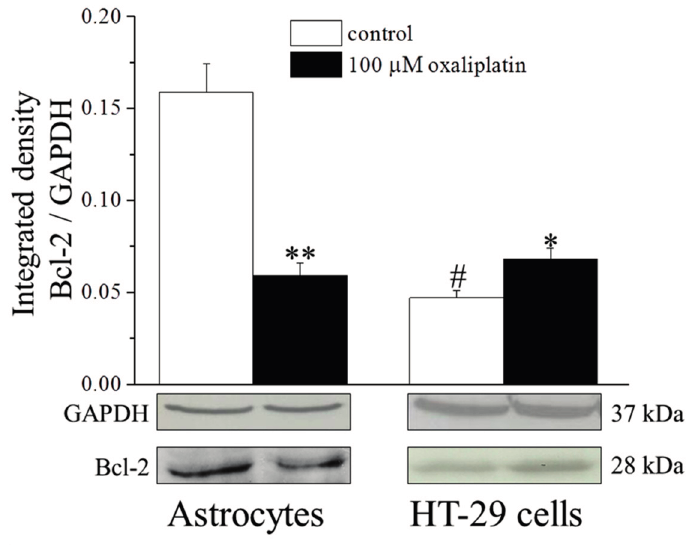
Figure 3. Bcl-2 protein expression. Astrocytes (10 6 cells/flask) and HT-29 (8 × 10 5 cells/flask) were incubated with 100 μ M oxaliplatin for 8 h and then cell lysates were analyzed by Western blot. Densitometric analysis ( top ) and representative immunoblot ( bottom ) are shown. Glyceraldehyde-3-Phosphate Dehydrogenase (GAPDH) was used as loading control and GAPDH normalization was performed for each sample. Values are expressed as integrated density making the ratio between Bcl-2 and GAPDH specific band intensities. Bars represent the mean ± S.E.M. of three experiments. * p < 0.05 vs . control, ** p < 0.01 vs . control and # p < 0.05 vs . astrocytes control.